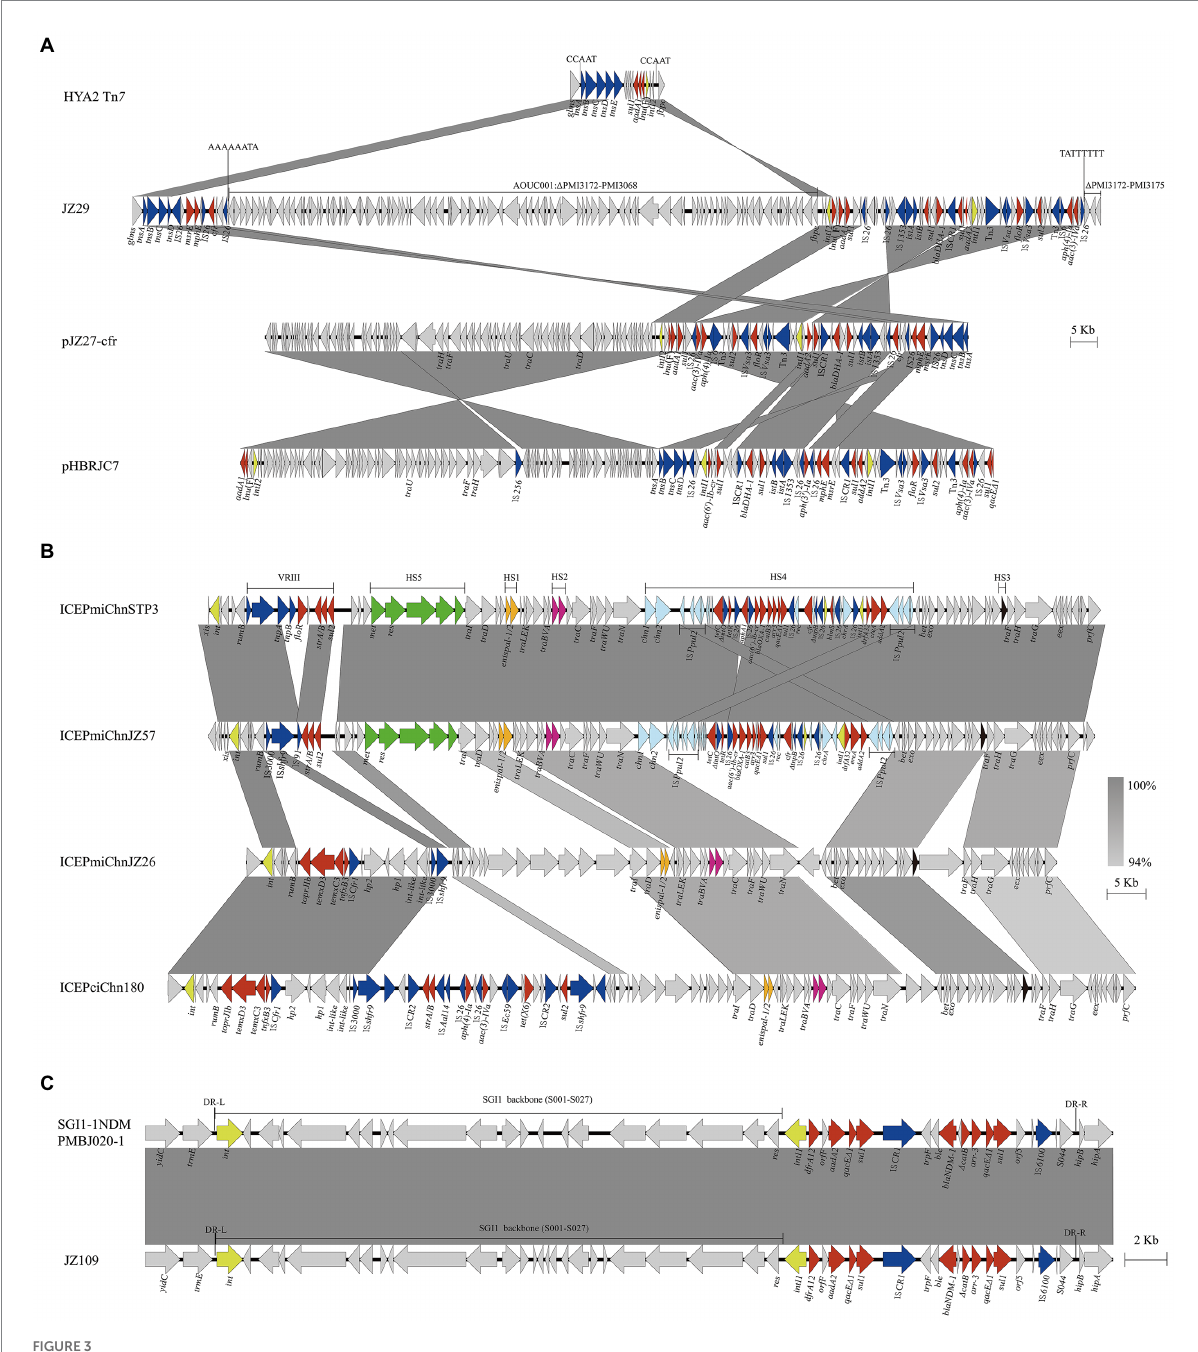
FIGURE 3 Genetic environments of clinically important antimicrobial resistance genes cfr , tmexCD3-toprJ1 and bla NDM-1 . These genes were associated with Tn 7 transposons in chromosome or plasmid (A) , SXT/R391 ICEs (B) , and SGI1 (C) . Genes and ORFs are shown as arrows, and their orientations of transcription are indicated by the arrowheads. Shared regions of >99% nucleotide sequence identity are shaded in gray. Integrase genes, resistance genes and transposase genes are in yellow, red, and blue, respectively. HS1-HS5 and VRIII represent the hot spots 1–5 and variable region III in SXT/R391 ICE. DR-L and DR-R represent the 18-bp direct repeats at the ends of